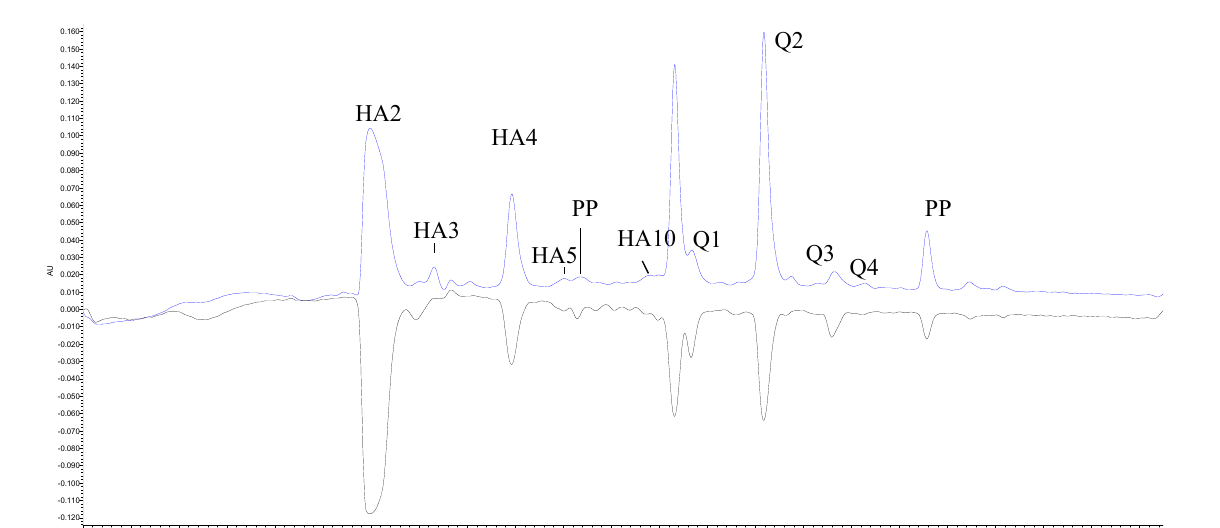
Figure 1. HPLC-PDA traces at 280 nm and on-line antioxidant detection (734 nm) basic polyphenols component of PrALe of Harcot cv. HA2-4- O -caffeoylquinic acid; HA3-3- p -coumaroyl-quinic acid; HA4-5- O -caffeoylquinic acid; HA5- p -coumaroyl-glucoside; HA8- cis -5- O -caffeoylquinic acid; HA10-4- O -feruloylquinic acid; Q1-quercetin-3- O -rutionoside; Q2-quercetin-3- O -rutinoside; Q3-quercetin-3- O -galactoside; Q4-keampferol-3- O -rutinoside; PP-polymeric procyanidins.